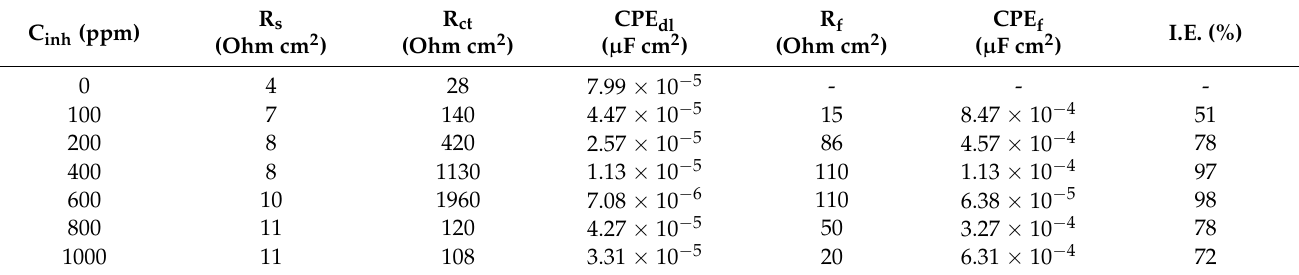
Figure 7. Equivalent electric circuits used to simulate EIS data for carbon steel in 0.5 M H 2 SO 4 in the ( a ) absence and ( b ) presence of α -linolenic acid. Table 3. Electrochemical parameters used to simulate the EIS results.